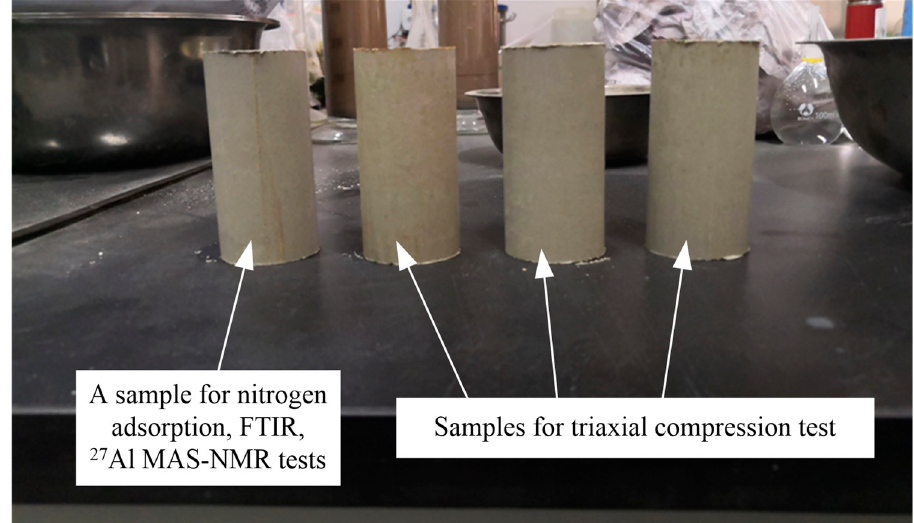
Figure 3. Four identical samples in laboratory (samples cured for 14 days case).